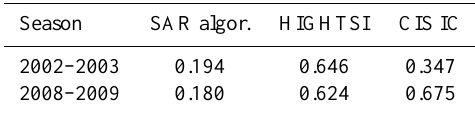
Table 3. Kolmogorov–Smirnov statistics compared to the EM ice